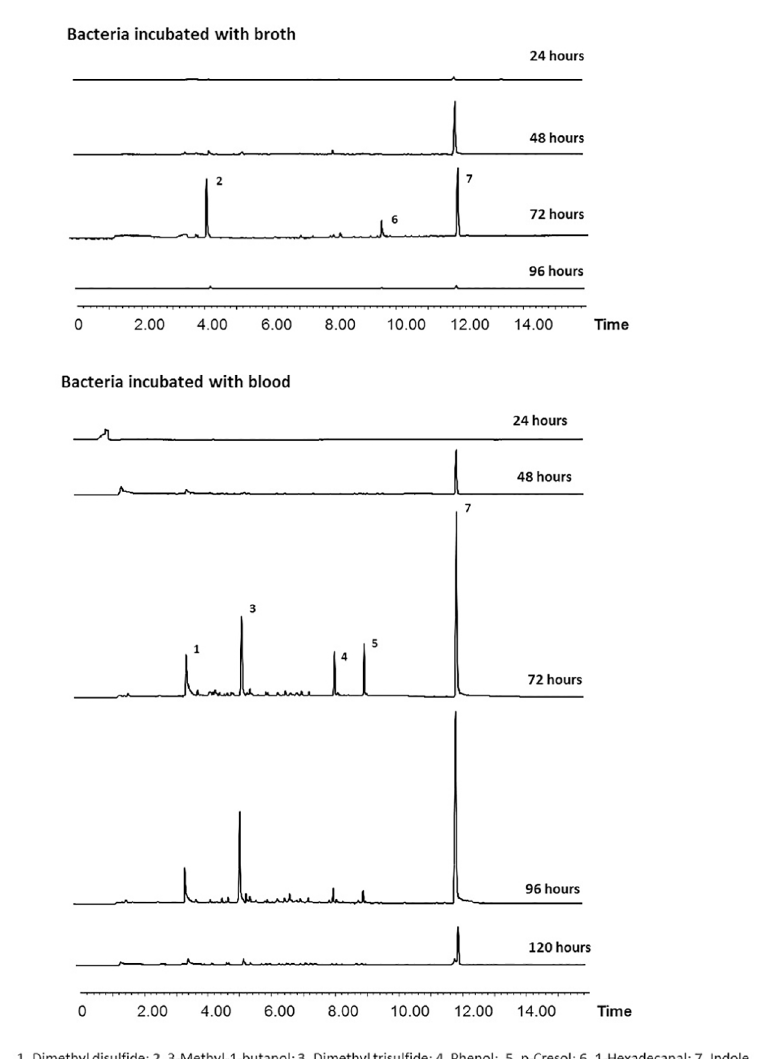
Fig 2. Comparisons of volatiles absorption on solid phase micro-extraction fibers of volatiles emitted from bacteria incubated with two culturing media, broth and bovine blood, with different incubation